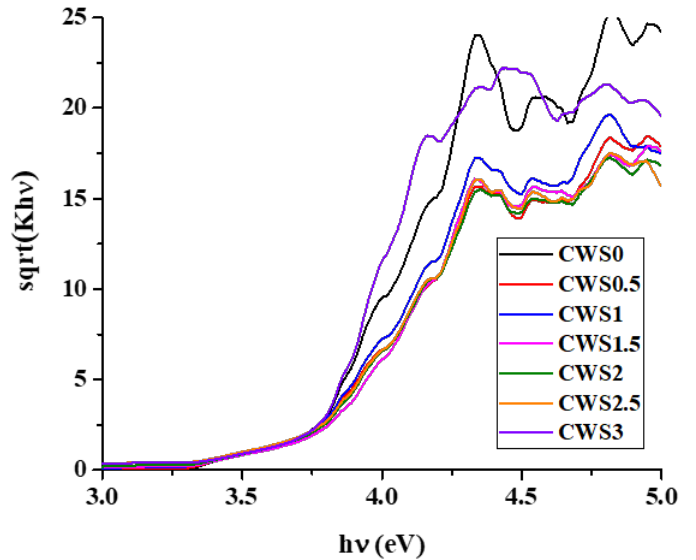
Figure 2. Kubelka–Munk representation of SrTiO 3 (CWS0) and SRTX samples for band gap energy Figure 2. Kubelka – Munk representation of SrTiO 3 (CWS0) and SRTX samples for band gap energy determination.